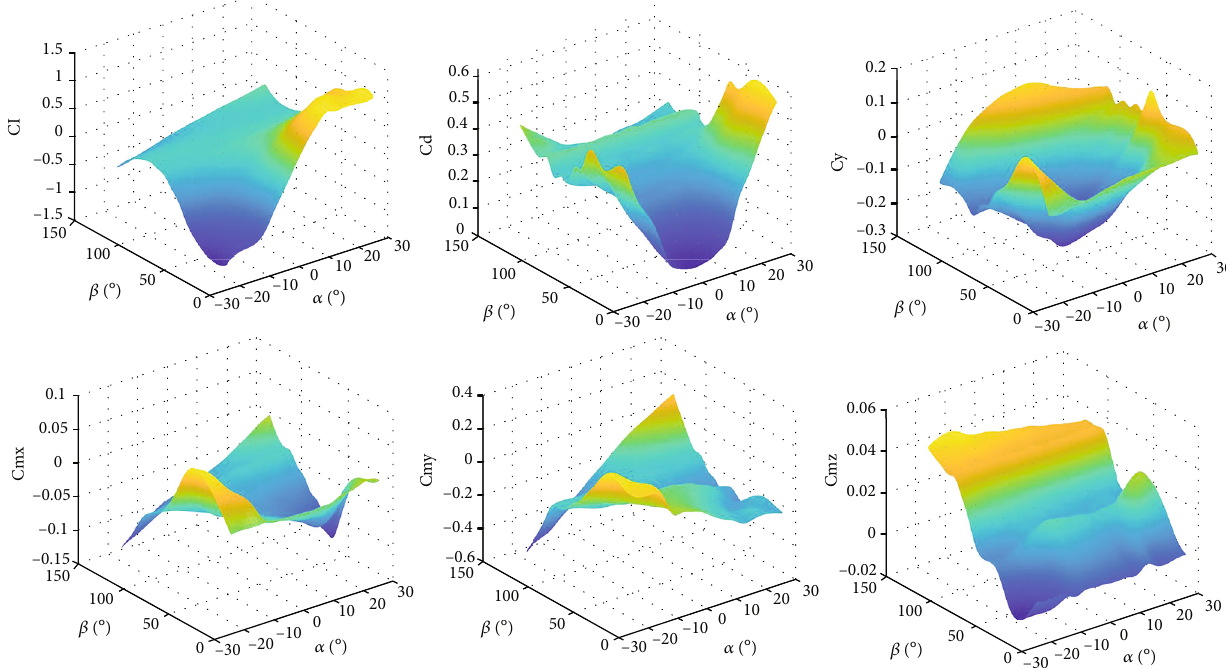
Figure 10: Aerodynamic model of the Quad-Plane.